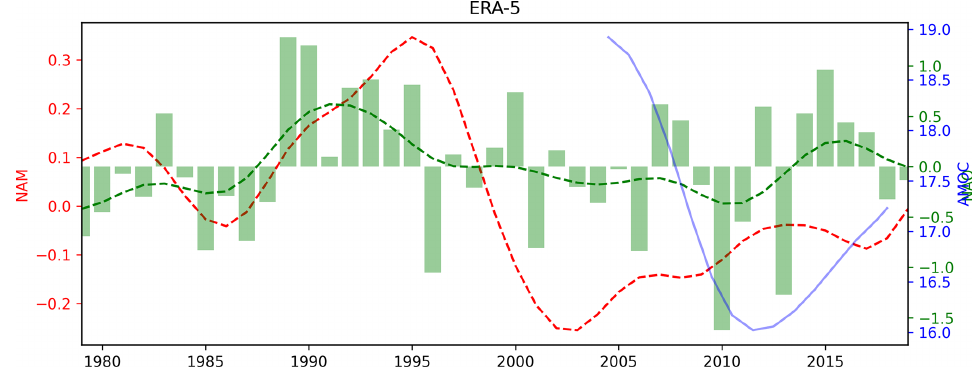
Figure 12. Time series of the Dec–Mar NAO index (green bars) and NAM 10 index (red bars) from the ERA5 dataset. Dashed lines correspond to indices shown by bars smoothed with a Gaussian filter ( σ = 2 years). Also included is the annual AMOC time series at 26 ◦ N from the rapid array dataset